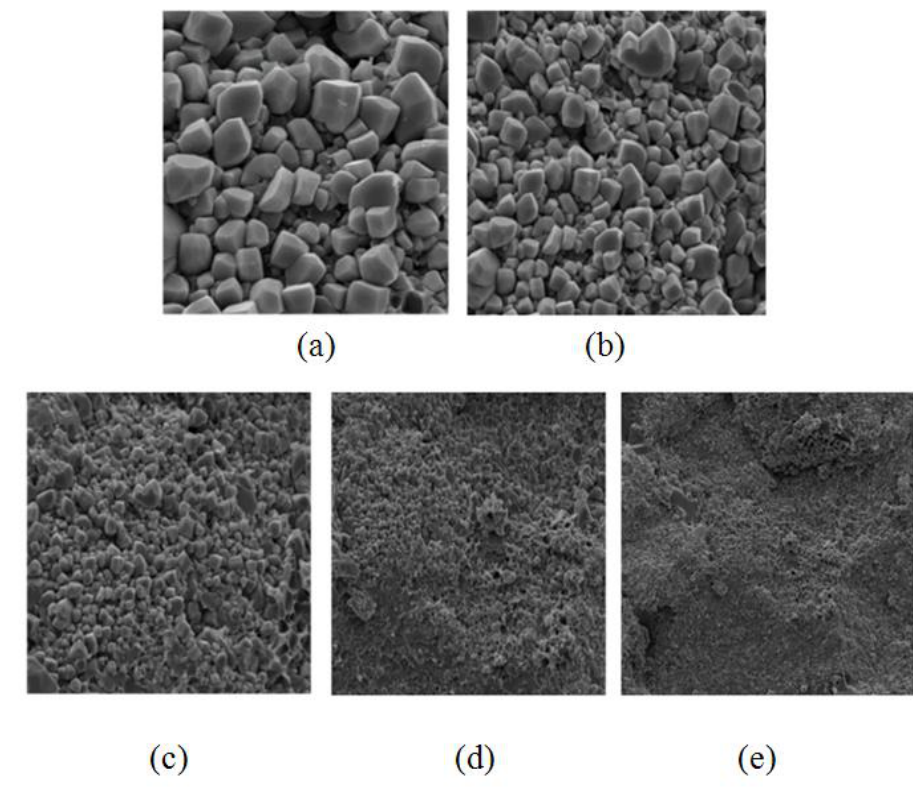
), 5600x (M ), 3000x (M ), 2 1 2 3